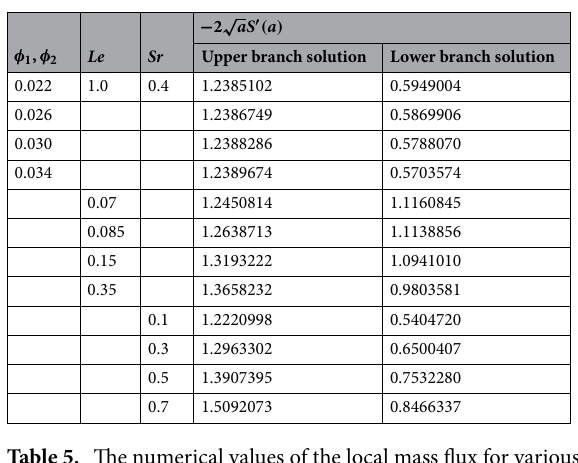
Table 5. The numerical values of the local mass flux for various controlling parameters.